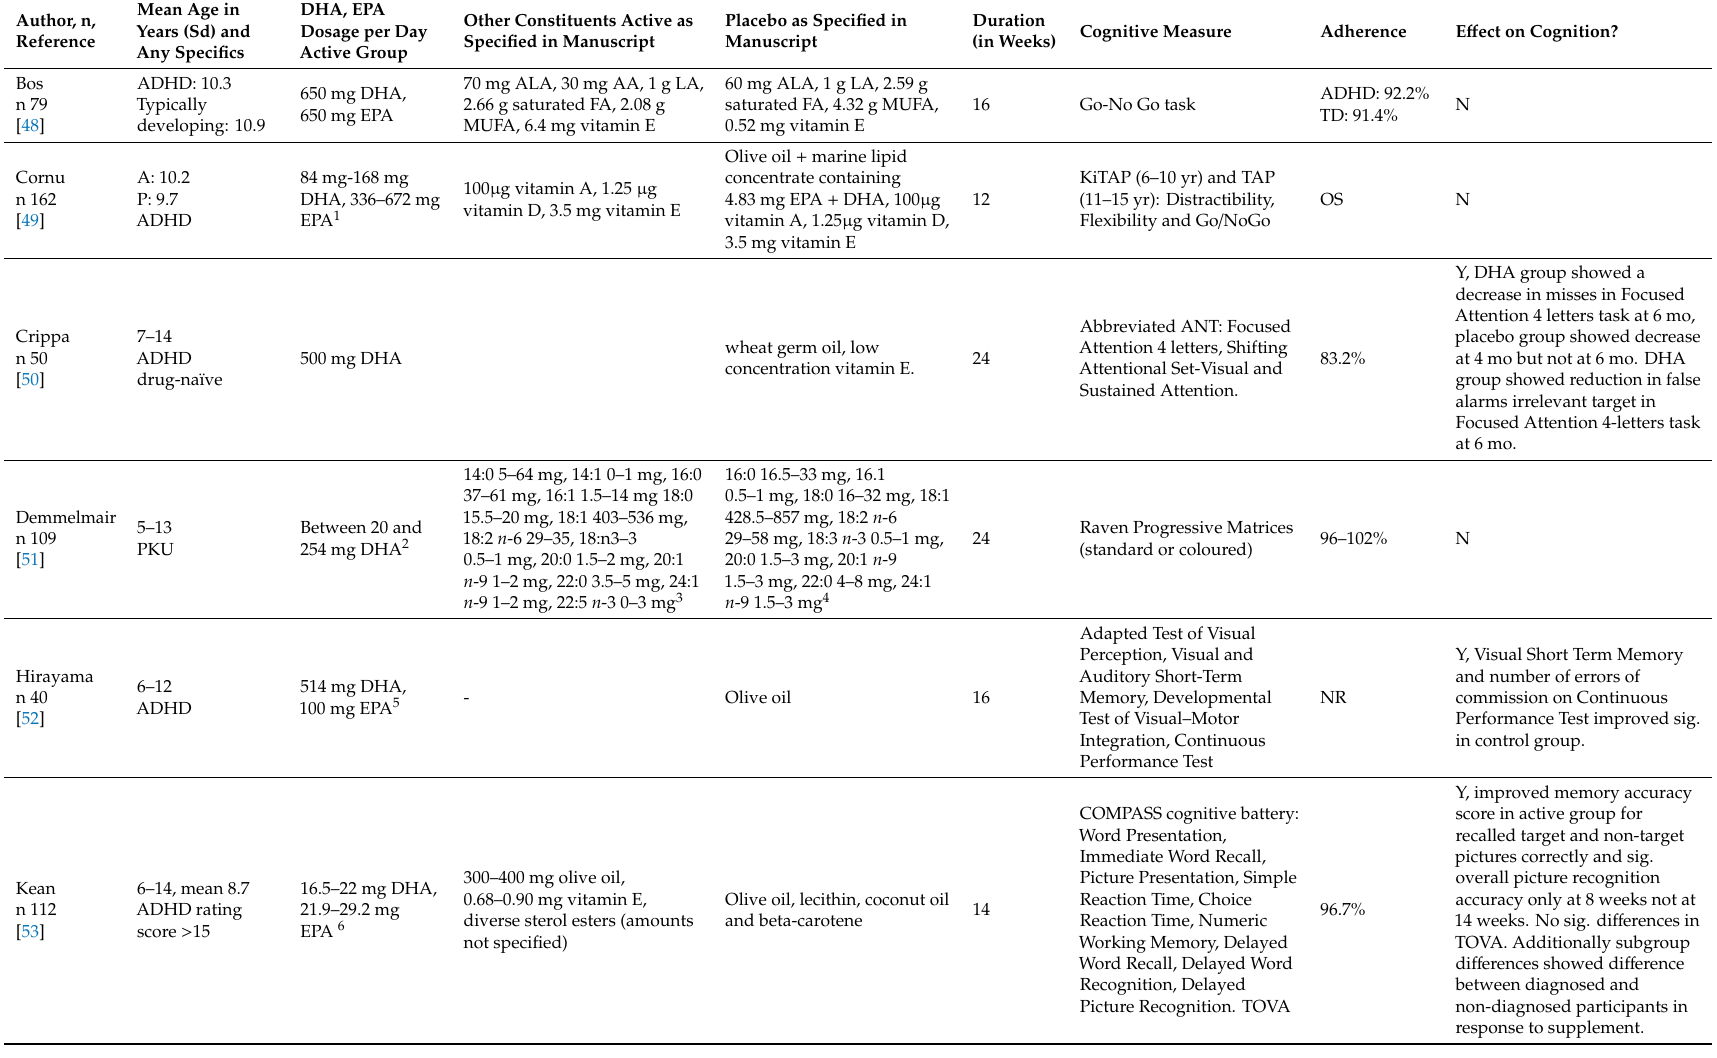
Table 2. Overview of studies supplementing children and adolescents with a disease or disorder with LCPUFA and including a cognitive measure as outcome